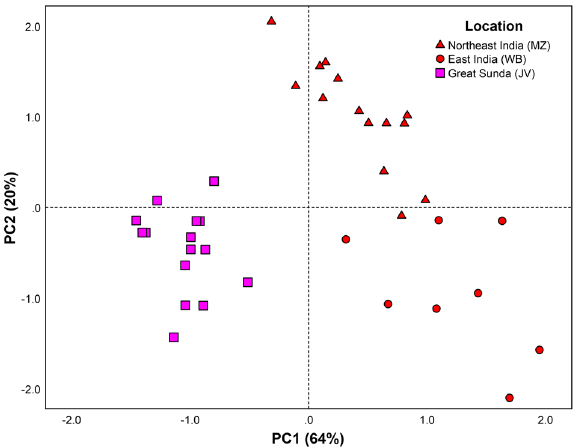
Figure 2. Ordination of Bungarus fasciatus populations from Mizoram (MZ), West Bengal (WB) and Java (JV) along the first two principal components based on a PCA of the characters Ve, BB, BT, and NBW. Total variance associated with PC1 and PC2 are 64% and 20%, respectively.